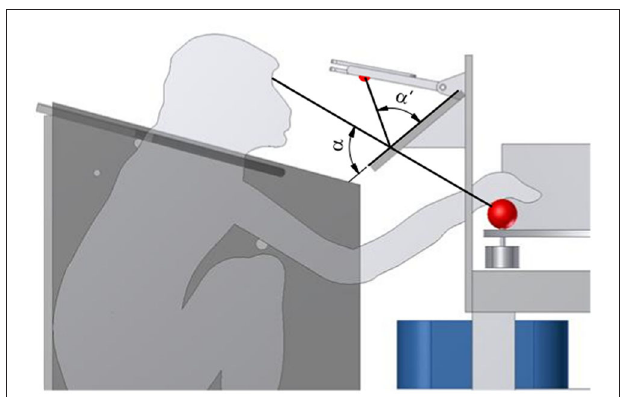
FIGURE 6 | Projection of the cue LED light. To superimpose the red cue LED light onto the front object, from the monkey’s perspective, a one-way mirror is placed, such that the angles α and α ′ match. This avoids an attention split between the object and the cue LED.